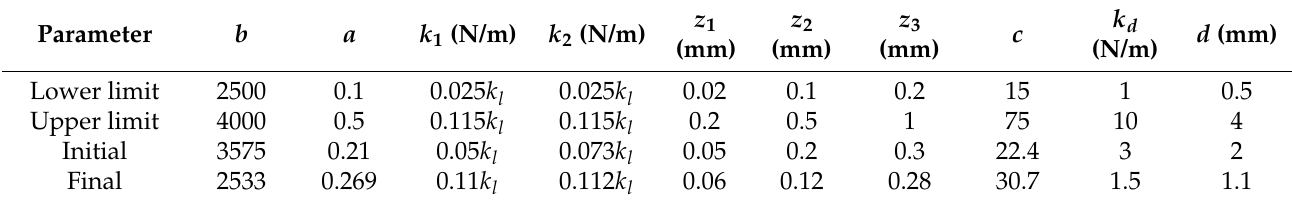
Table 3. Initial and final parameters of the rubber isolator in the identification